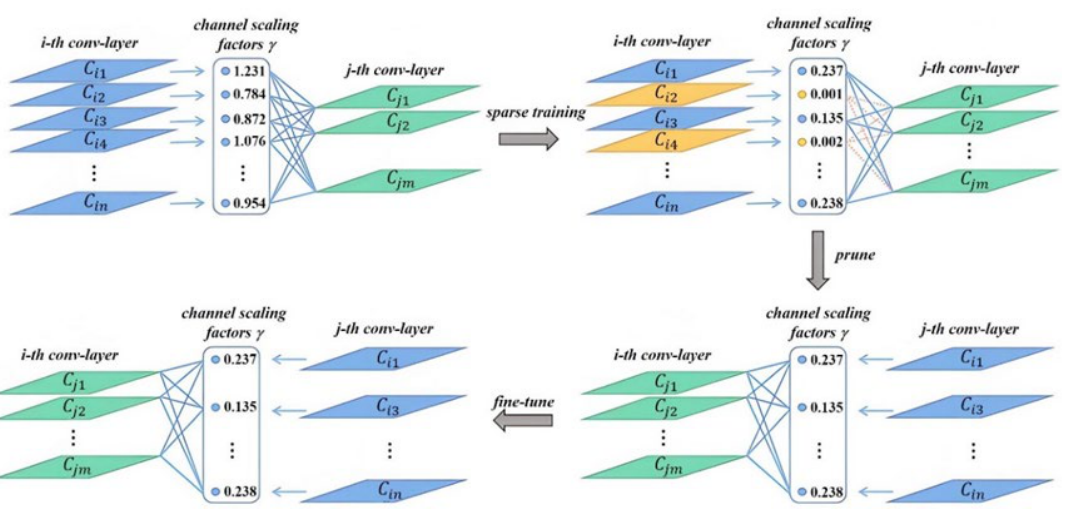
Figure 5. The flow of the channel pruning algorithm (The entire pruning process is divided into three steps: sparse training, pruning channel, and achieving accuracy recovery through fine-tuning).